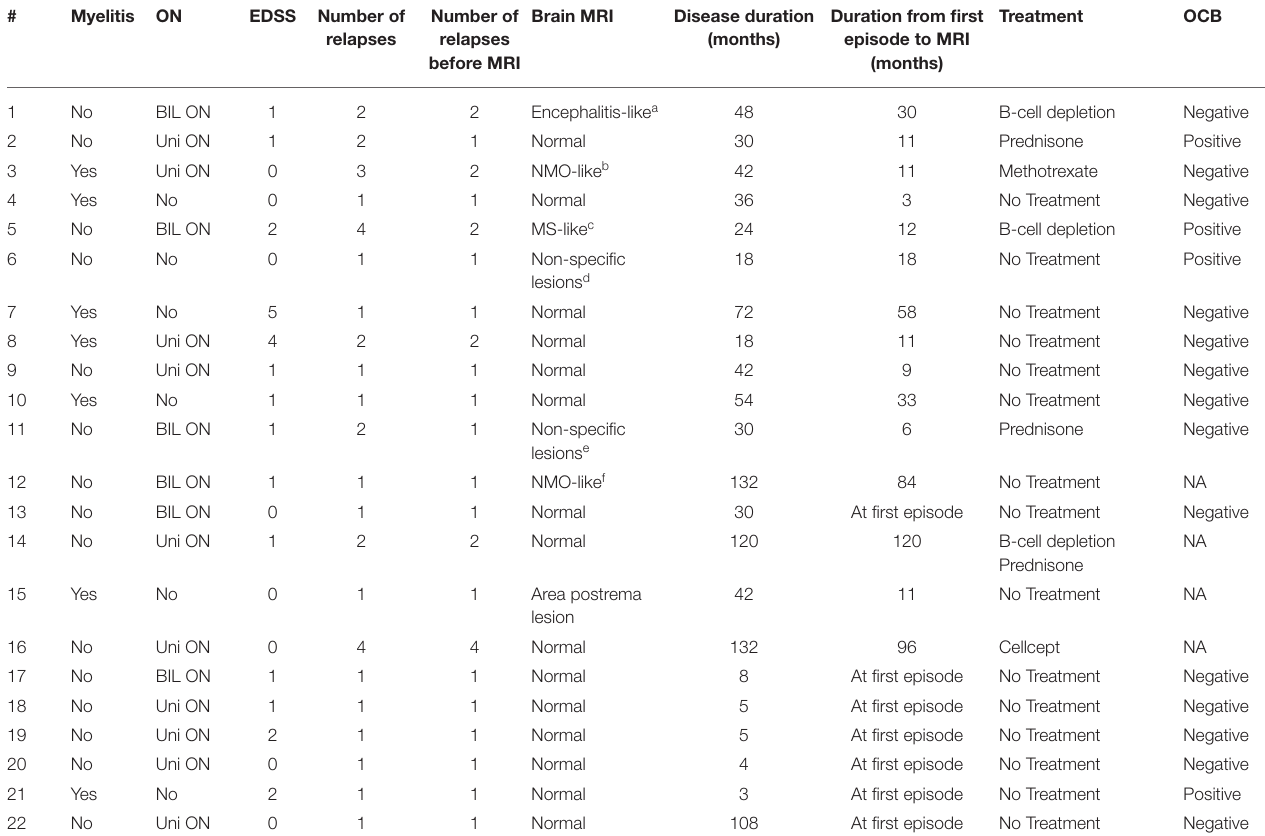
TABLE 1A | Clinical and imaging data of MOGAD patients. # Myelitis ON EDSS Number of